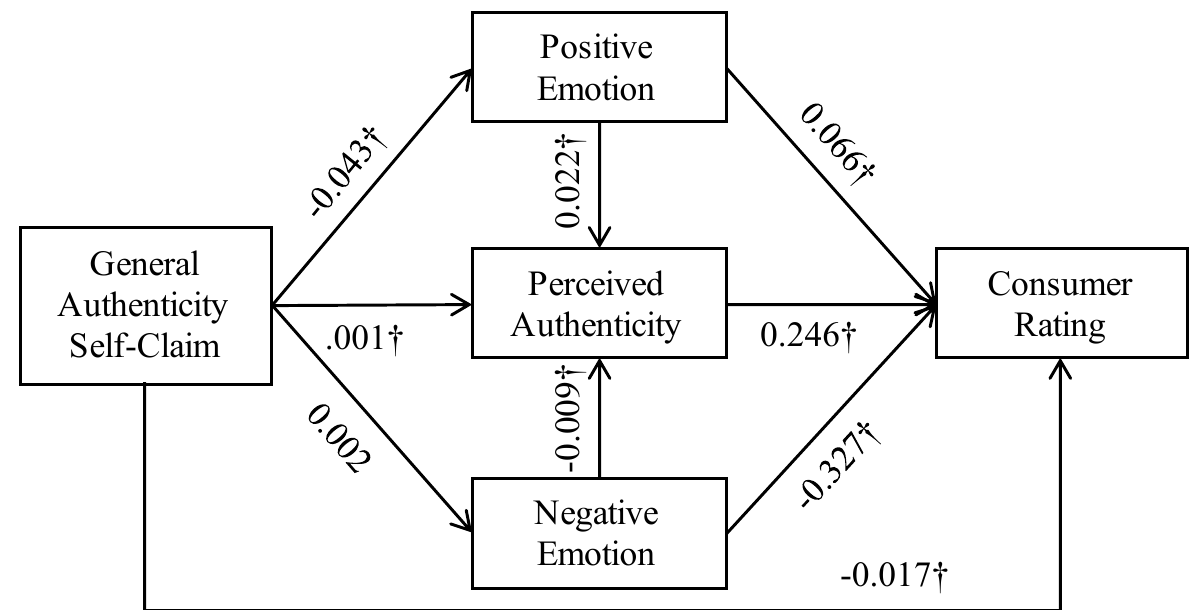
Figure 2: Structural equation model of value ratings (study 1). N = 450,492. † p < 0.01, ∗ p <